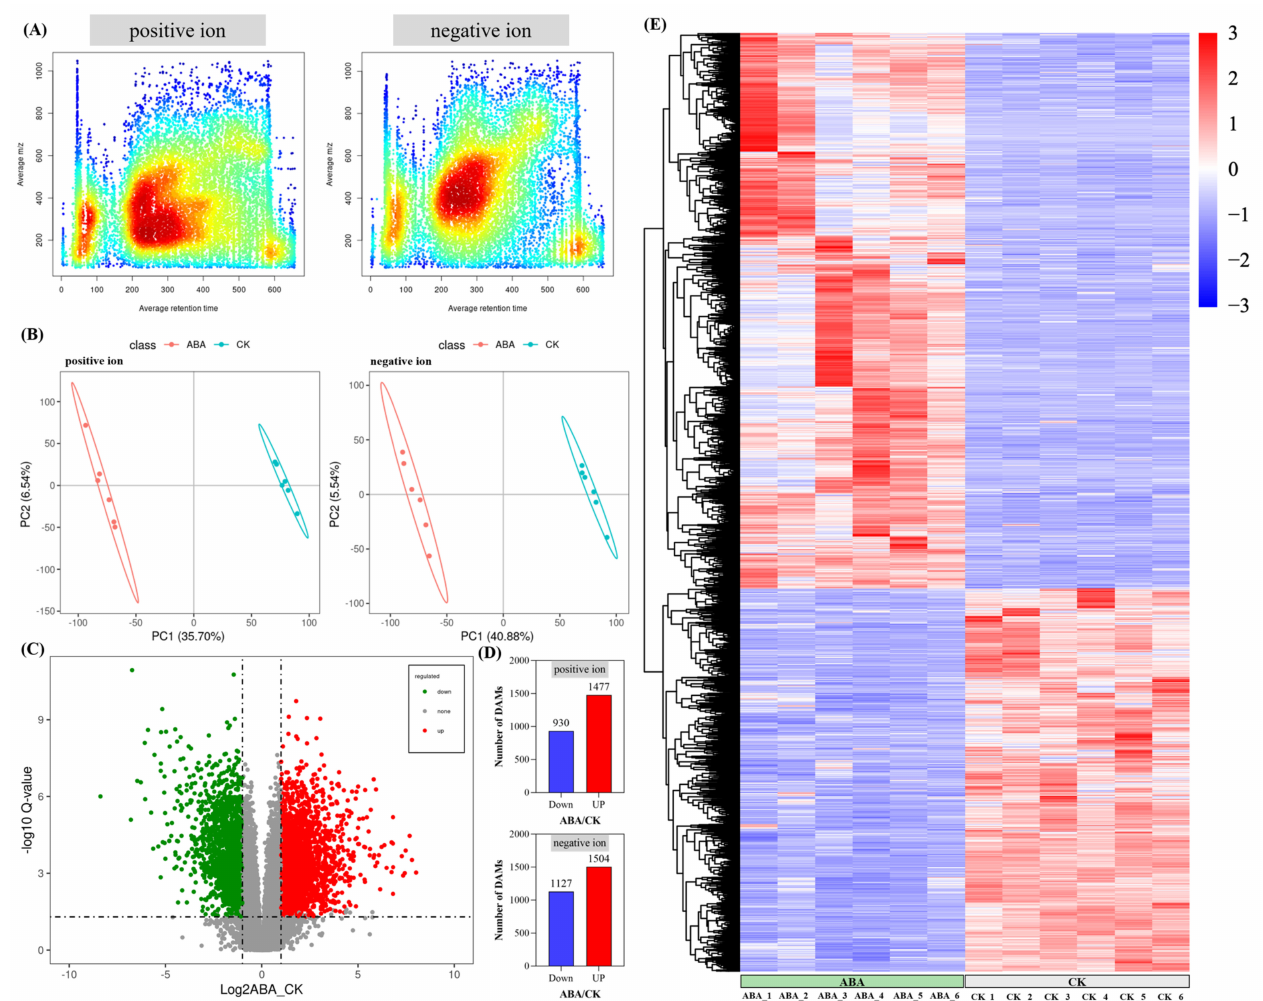
Figure 6. Basic metabolite information of ABA and CK based on widely untargeted metabolomic analysis. ( A ) m/z-RT distribution of metabolites. ( B ) PLS-DA score plot of metabolites. ( C ) Sig- nificance analysis of the DAMs between the ABA and CK by volcano plot. ( D ) Number of DAMs between ABA and CK. ( E ) ABA regulated the metabolites of A. argyi